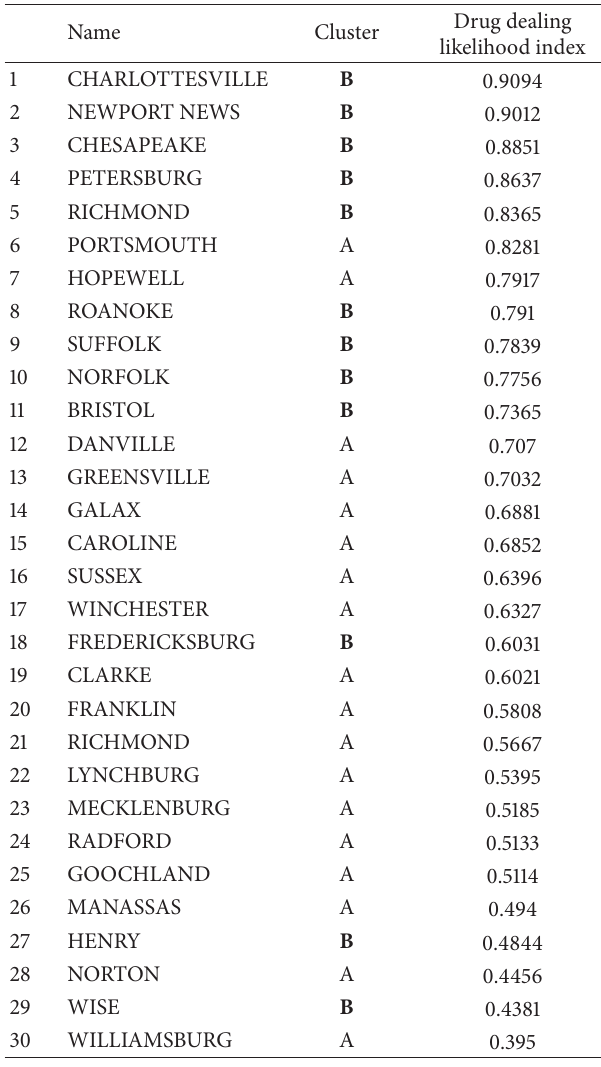
Table 8: Likelihood index and clustering for drug